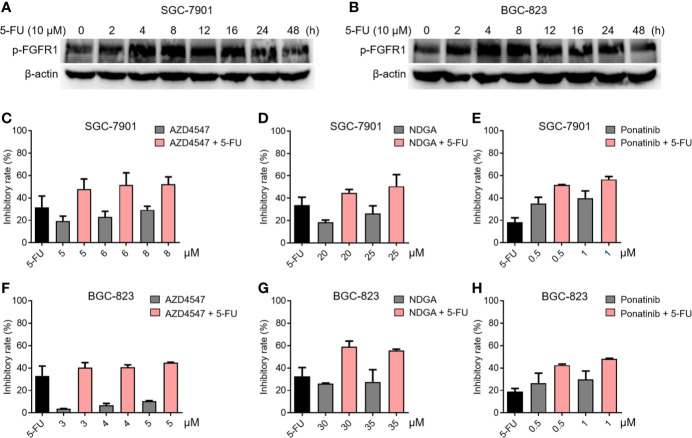
The relationship between FGFR1 and chemotherapy resistance in gastric cancer cells. The level of p-FGFR1 increased at early time points of 5-FU treatment in SGC-7901 (A) and BGC-823 cells (B). The inhibitory rates of 5-FU (6.25 μM), FGFR1 inhibitors (AZD4547, NDGA or Ponatinib) or their combination treatment in SGC-7901 (C–E) and BGC-823 cells (F–H).